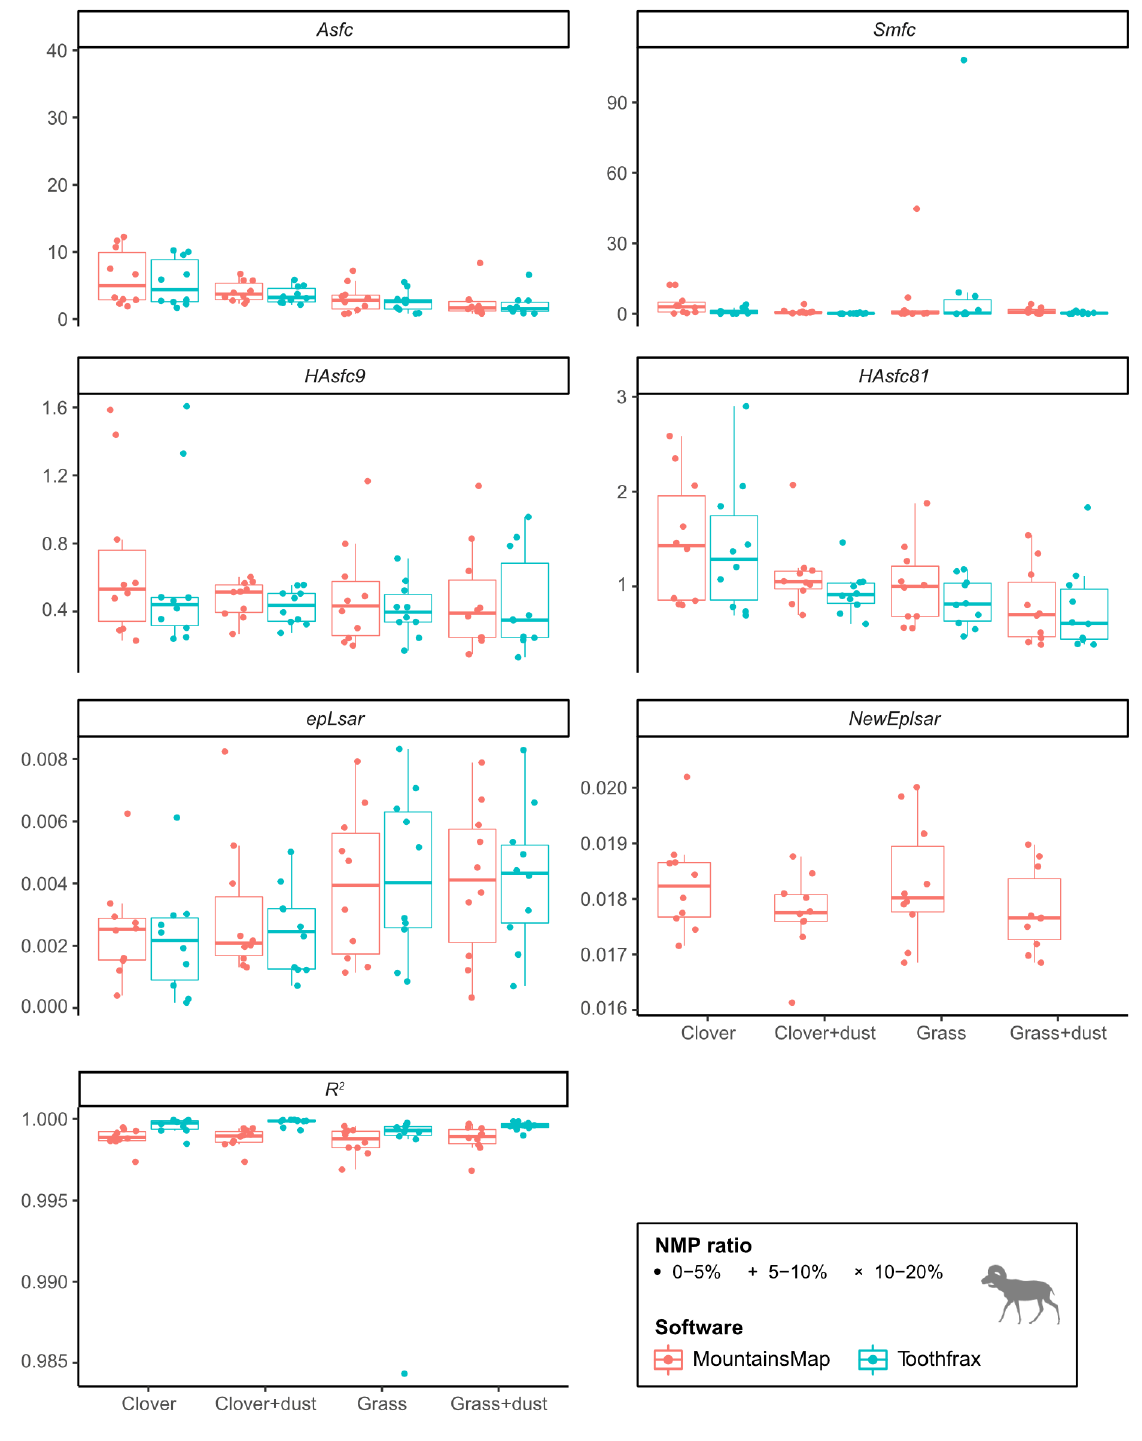
Fig. 1. Boxplots of the Scale-Sensitive Fractal Analysis (SSFA) parameters for the sheep dataset. The boxes represent the interquartile range (IQR), i.e., between the 25 th and 75 th percentile, with the median shown as a thick horizontal line. The bars extend up to 1.5 IQR on each side of the box. The points are spread horizontally within each group to avoid overlap for readability. NMP = non-measured points. See text for details on surface parameters and treatments. Sheep silhouette from PhyloPic (phylopic.org, Scott Hartman, Public Domain Dedication 1.0